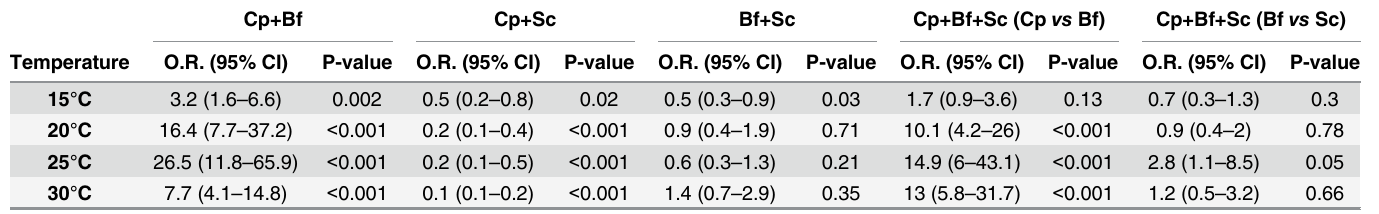
Table 3. Results of GLM analysis comparing larval survival between borer species in multi-species communities at different constant temperatures. Cp+Bf Cp+Sc Bf+Sc Cp+Bf+Sc (Cp vs